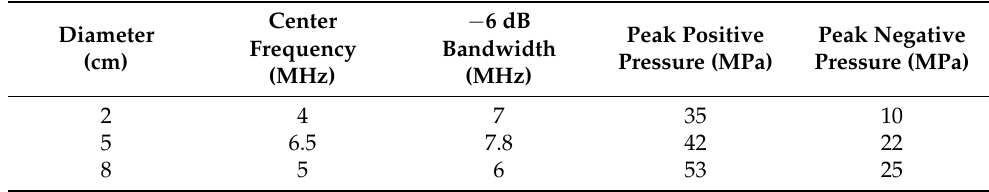
Figure 2. Graph representing the peak positive and negative pressures of the shock waves generated by CNT-PDMS composite transducers of different diameters. Figures ( a – c ) show the time domain signals, while ( d – f ) show the frequency domain analysis of the 2 cm, 5 cm, and 8 cm CNT-PDMS composite transducers, respectively. Table 1. Center frequencies, bandwidths, and peak positive and negative pressures of 2 cm, 5 cm, and 8 cm CNT-PDMS composite transducers.